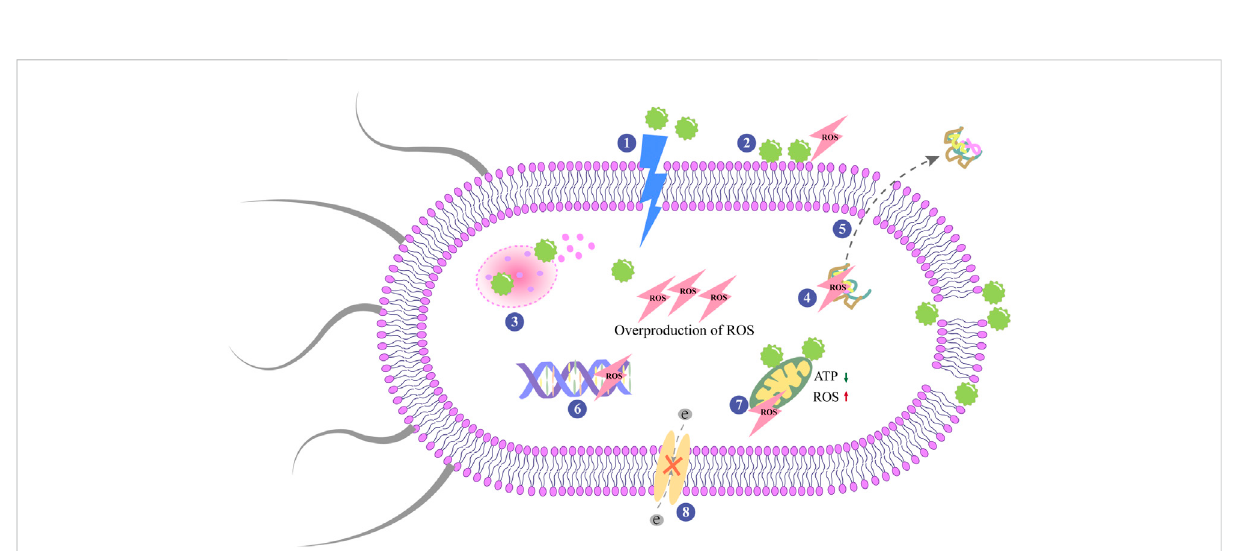
FIGURE 3 Antibacterial mechanisms on nanoparticles surfaces. The central modes of actions are: 1) The rupture and perforation of membrane; 2) ROS production; 3) Lysosomal destroyed by NPs and result in the release of the contents; 4) Protein damage; 5) Protein leakage; 6) Inhibition of DNA replication; 7) Mitochondrial dysfunctioning; 8) Interruption of electron